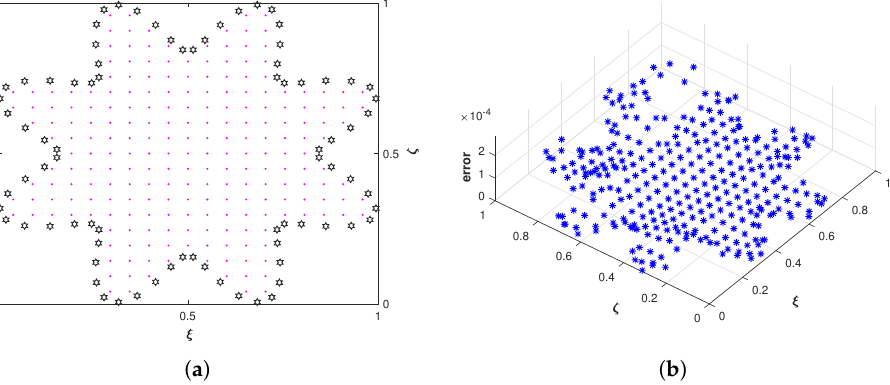
Figure 15. ( a ) Star Shape domain N = 305. ( b ) absolute error of Problem 4 with α = 0.75, N = 305, n = 30, and M = 26. It can be seen that the method has produced accurate results for a relatively small number of nodes N in the Star shape